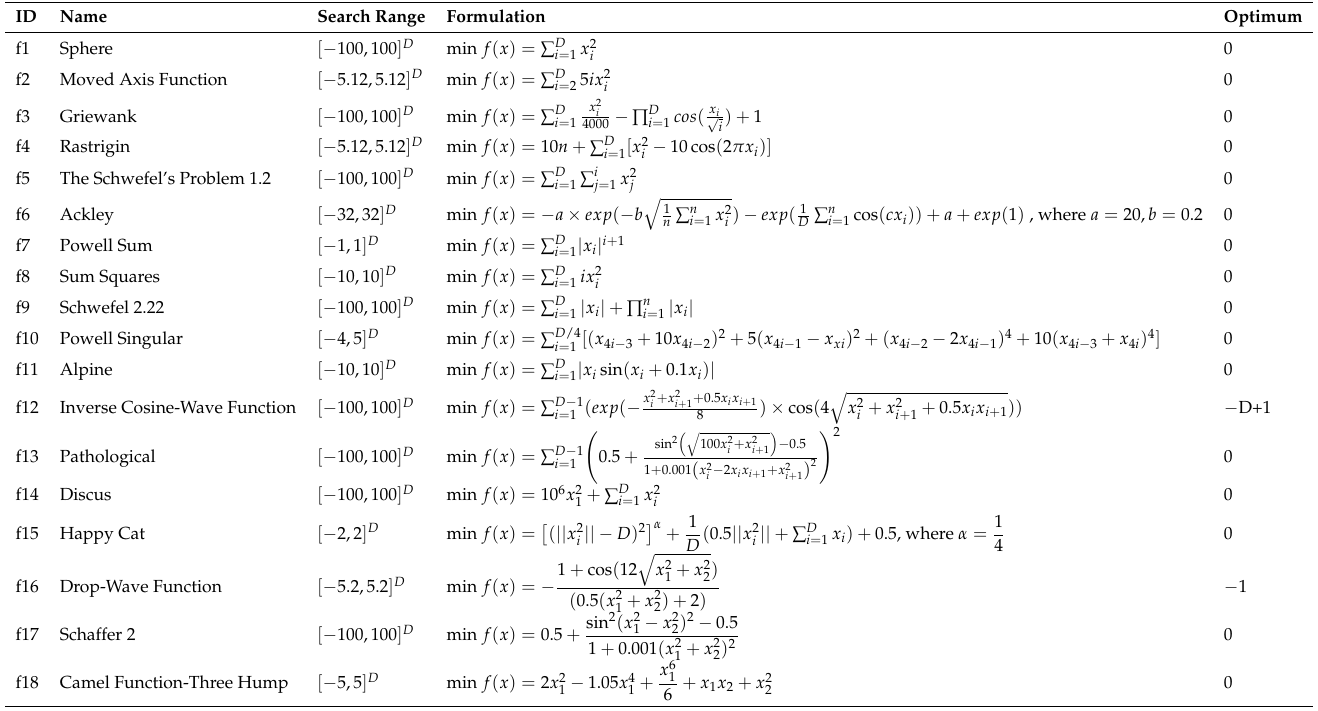
Table 2. Function details for benchmarks problem set